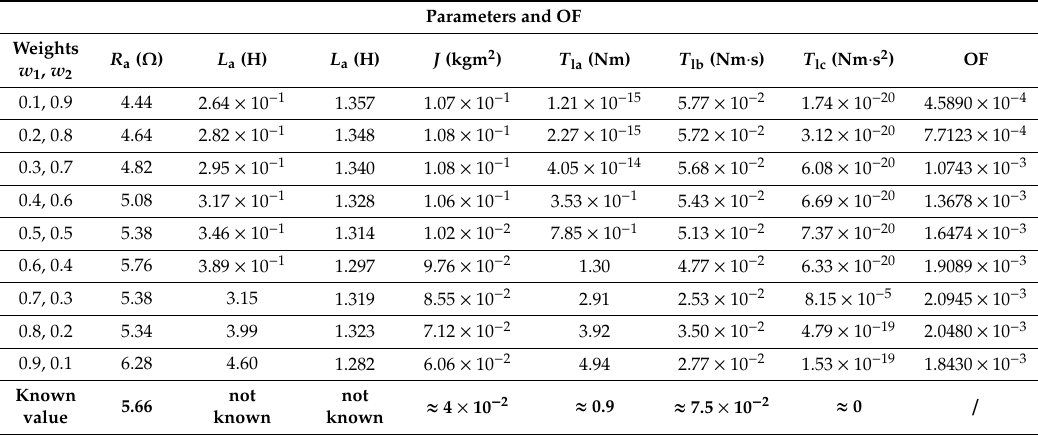
Table 23. Calculated parameters with di ff erent weights using RK for MD4 (mean values for 50 independent